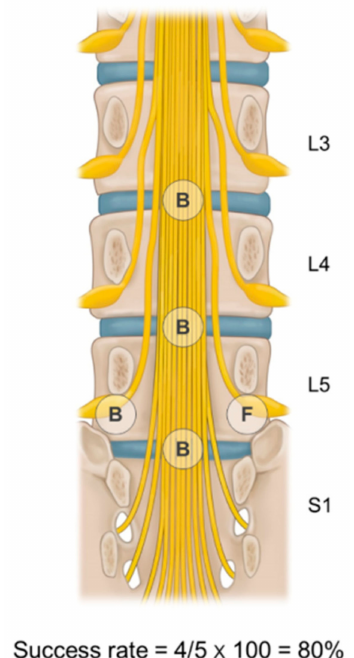
Figure 1. Determination of success rate of balloon adhesiolysis for multiple target sites. The rate of successful balloon adhesiolysis is defined as the number of successful ballooning procedures divided by the number of target lesions. In this schematic picture, the success rate is 80% (4 successful ballooning procedures out of 5 target lesions). B—ballooning success; F—failure of